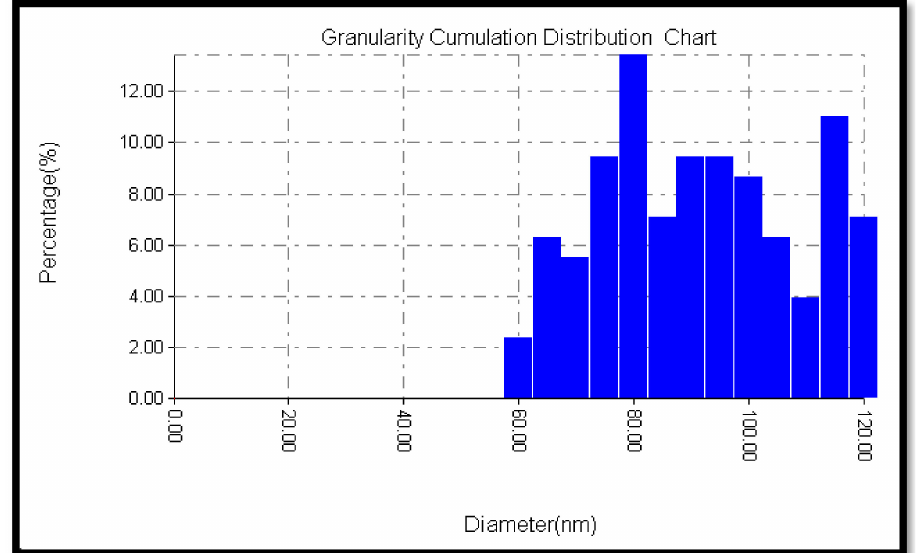
Figure 6. Particle size distribution of the SiO 2